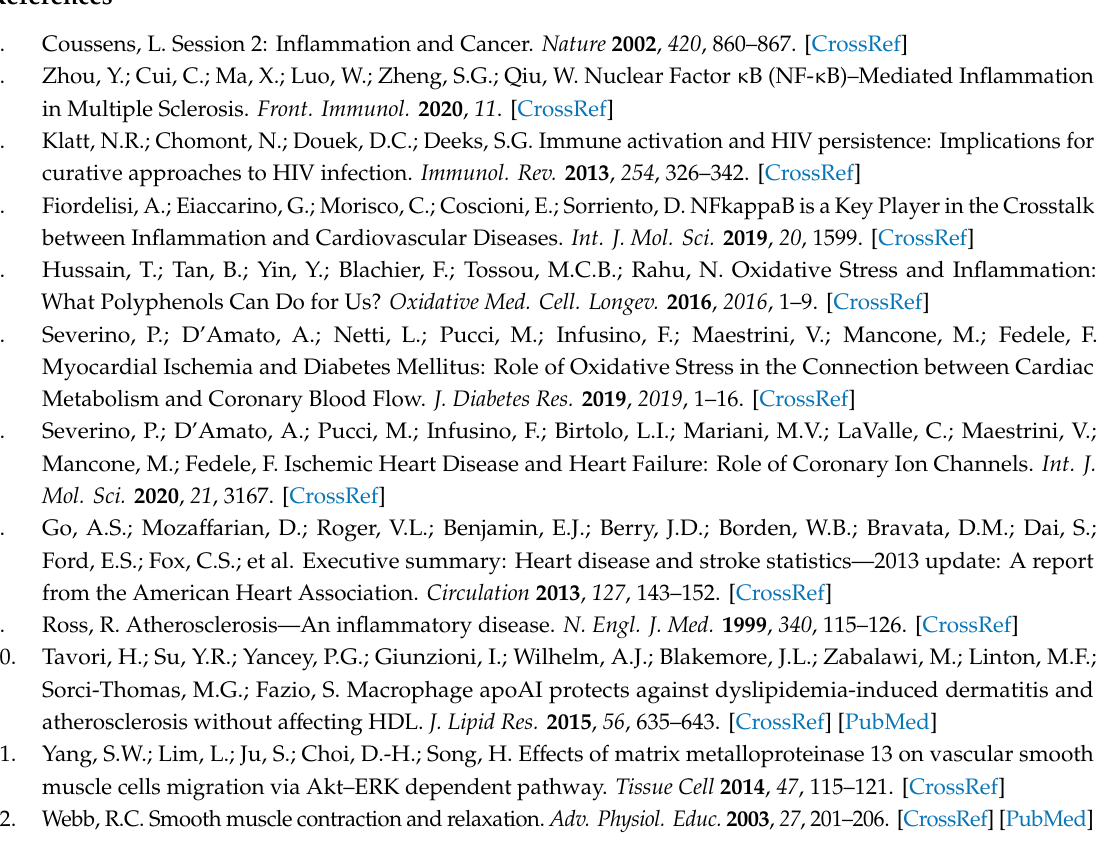
Figure S1: Protein label-free-quantification (LFQ) intensities of the study samples. Figure S2: IPA network analysis of the modified proteins. Figure S3: IPA network analysis of the modified proteins. Figure S4: Immunocytochemistry staining assessing the expression of LeptR (FITC, Green). Figure S5: IPA network analysis of the modified proteins in response to leptin 24 h stimulation relative to control in RASMC. Figure S6: IPA network analysis of the modified proteins in response to leptin 48 h stimulation relative to control in RASMC. Table S1: Comparative list of proteins in BK stimulation for 24 h compared to controls. Table S2: Comparative list of proteins in BK stimulation for 48 h compared to controls. Table S3: Comparative list of proteins in leptin stimulation for 24 h compared to controls. Table S4: Comparative list of proteins in leptin stimulation for 48 h compared to